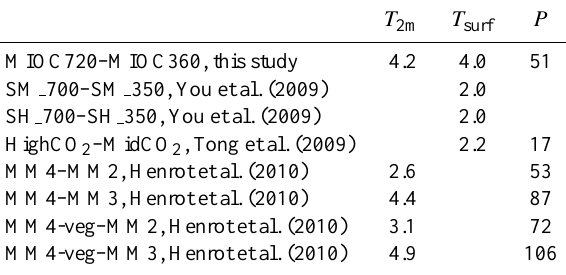
Table 3. Model sensitivity to a doubling of atmospheric CO 2 for global mean temperature T (in ◦ C) and precipitation P (in mma − 1 ). The equilibrium climate sensitivity and transient climate response, respectively, according to the IPCC (AR4) report is 3.4K and 2.2K for ECHAM5/MPI-OM, and 2.7K and 1.5K for CCSM3. The average climate sensitivity of all IPCC models is 3.2K ± 0.7K (IPCC,